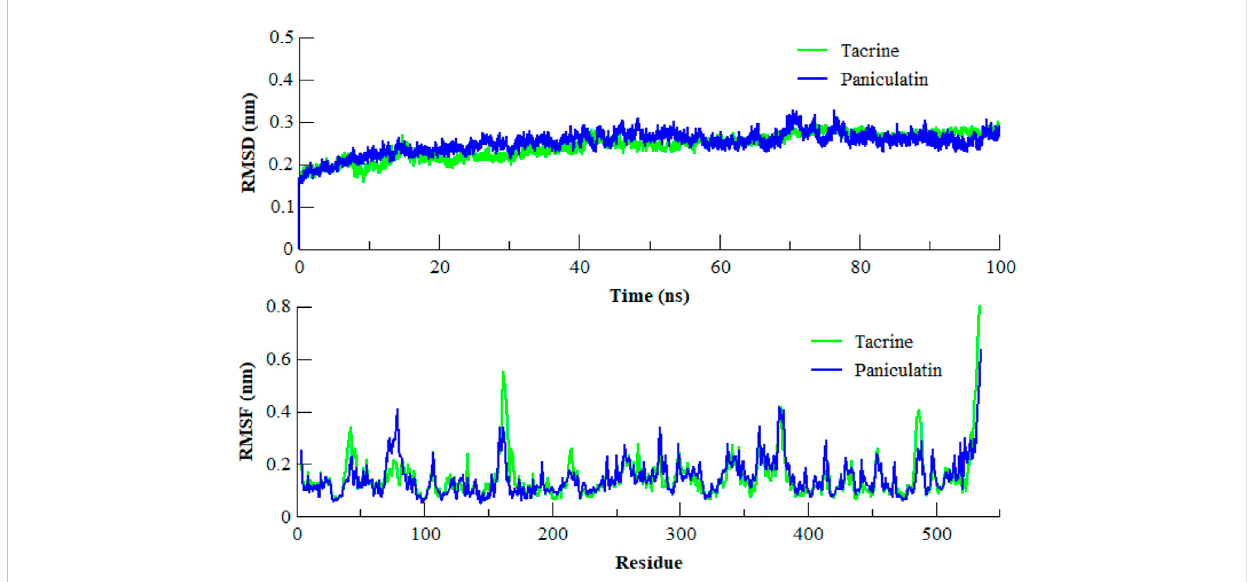
FIGURE 5 RMSD and RMSF of the backbone atoms (CA, N, and C) of AChE in complex with Paniculatin ( 3 ) and Tacrine with respect to the initial structure as a function of time. RMSD of Tacrine shown in green color while Paniculatin ( 3 ) shown in blue color.